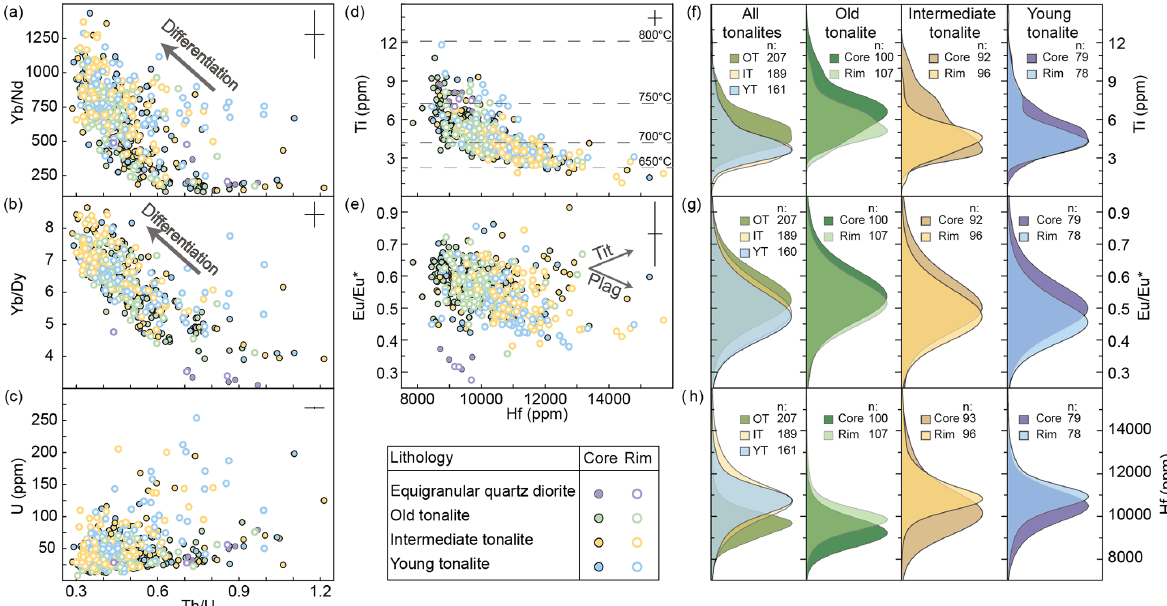
Figure 4. Covariation diagrams (a–e) and probability density plots (f–h) of in situ geochemical data obtained by LA-ICP-MS. Panels (a) – (c) are plotted against Th / U as an indicator for fractionation, whereas panels (d) and (e) are plotted against Hf as the fractionation proxy. Arrows labelled “fractional crystallisation” indicate the approximate predicted direction zircon geochemistry would migrate given fractional crystallisation of zircon ± apatite ± titanite ± amphibole. Arrows labelled “plag” and “tit” point in the predicted direction of zircon geochemistry evolution during co-crystallisation with plagioclase or titanite. Zircons from the three tonalite porphyries are considered to have crystallised from the same magma reservoir, whereas zircons from the equigranular quartz diorite (purple) are unrelated (see text for discussion). Temperature lines in panel (d) are calculated with an assumed aSiO 2 = 1 and aTiO 2 = 0 . 7 based on Ferry and Watson (2007: see text for discussion). The crosses in the top right corners illustrate average analytical 2 σ uncertainties. Probability density plots (after Vermeesch et al., 2013) illustrate differences between different samples and core and rim analyses within each sample. The axes of probability density plots in panels (f) and (g) are aligned with the axes of panels (d) and (e) .